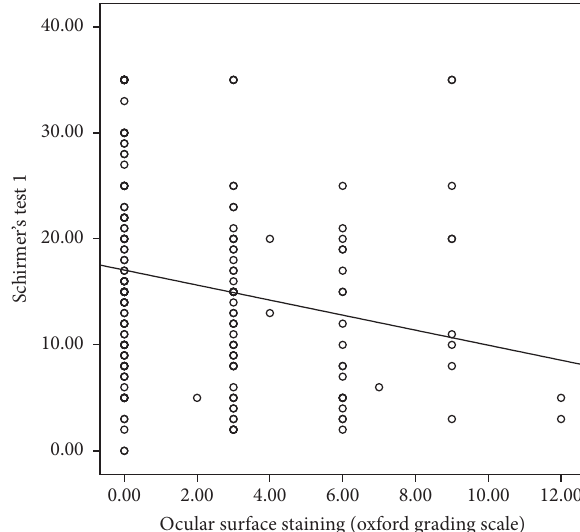
Figure 2: Correlation between Schirmers test 1 and meibomian gland expressibility.